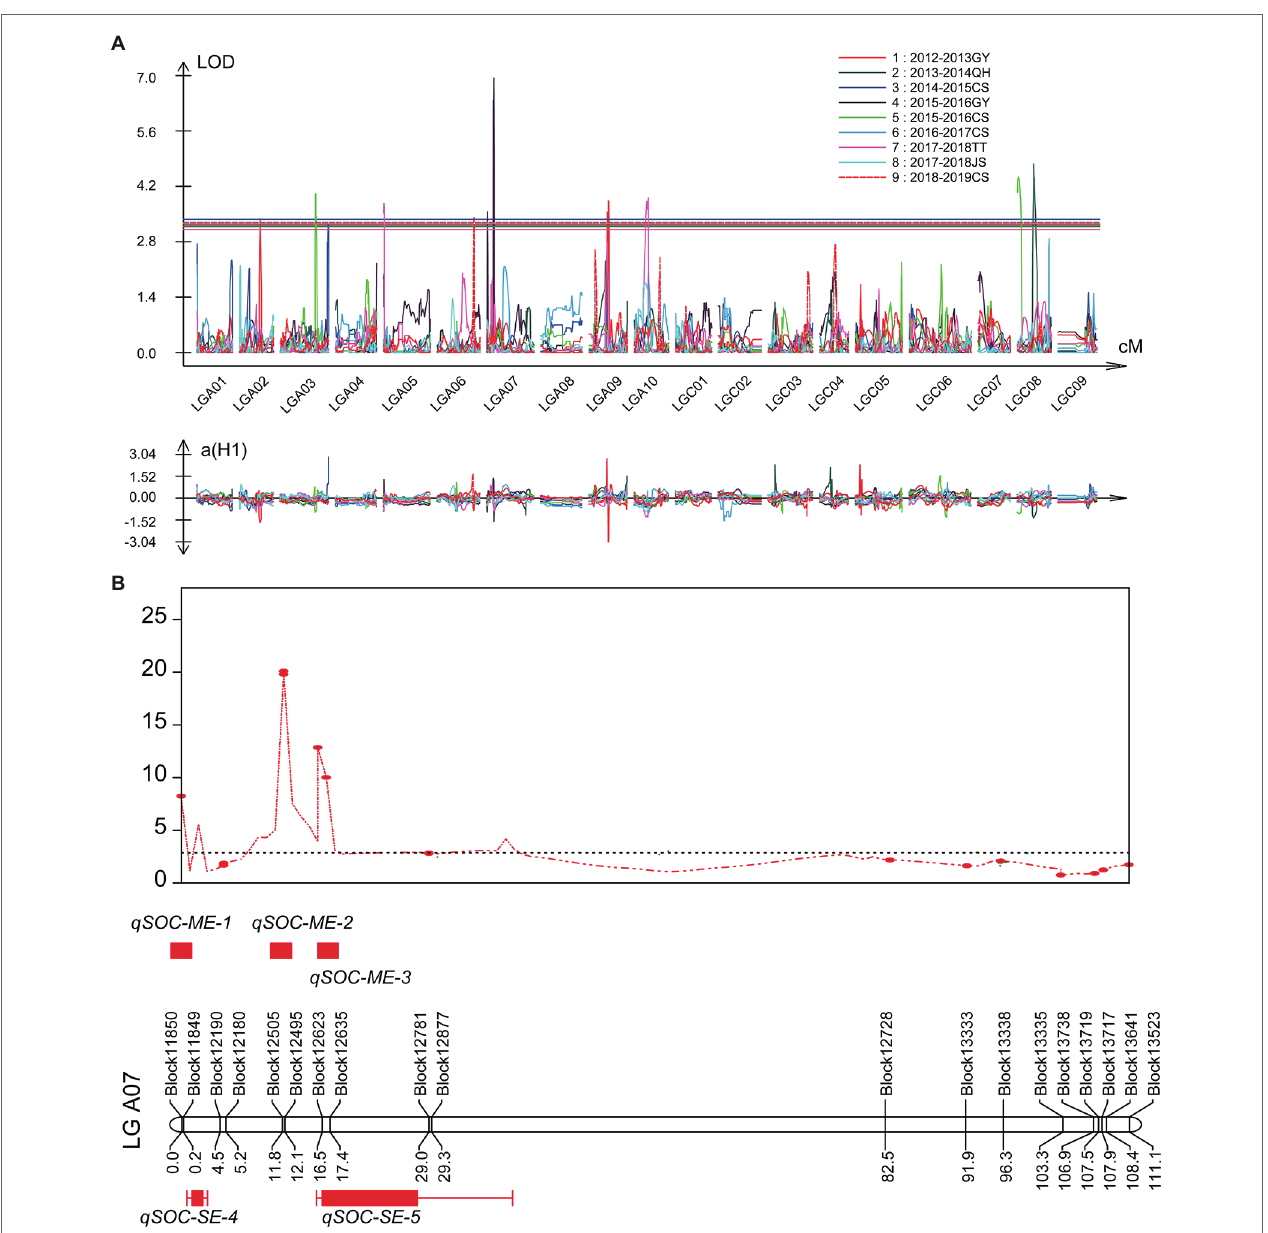
FIGURE 4 | Quantitative trait loci (QTLs) identification for SOC in single and multi-environments. (A) The various colors represented the QTL identified in different single environments. (B) Co-localization analysis of the major QTLs identified in single and multi-environments on linkage group A07. ME represented multi- environments; SE represented single